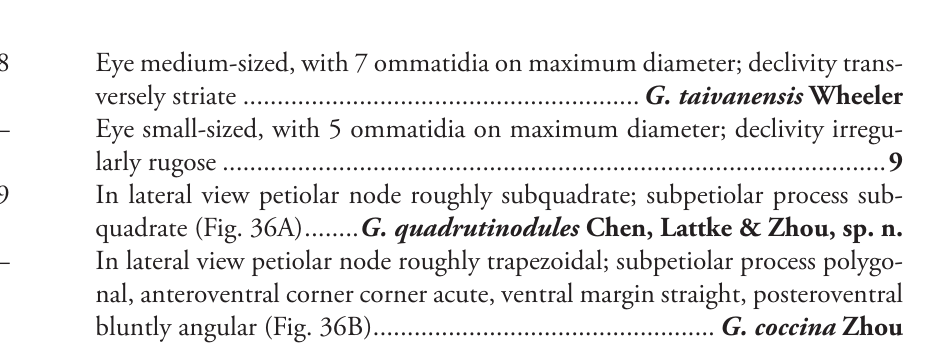
bluntly angular (Fig. 36B) .................................................. G. coccina